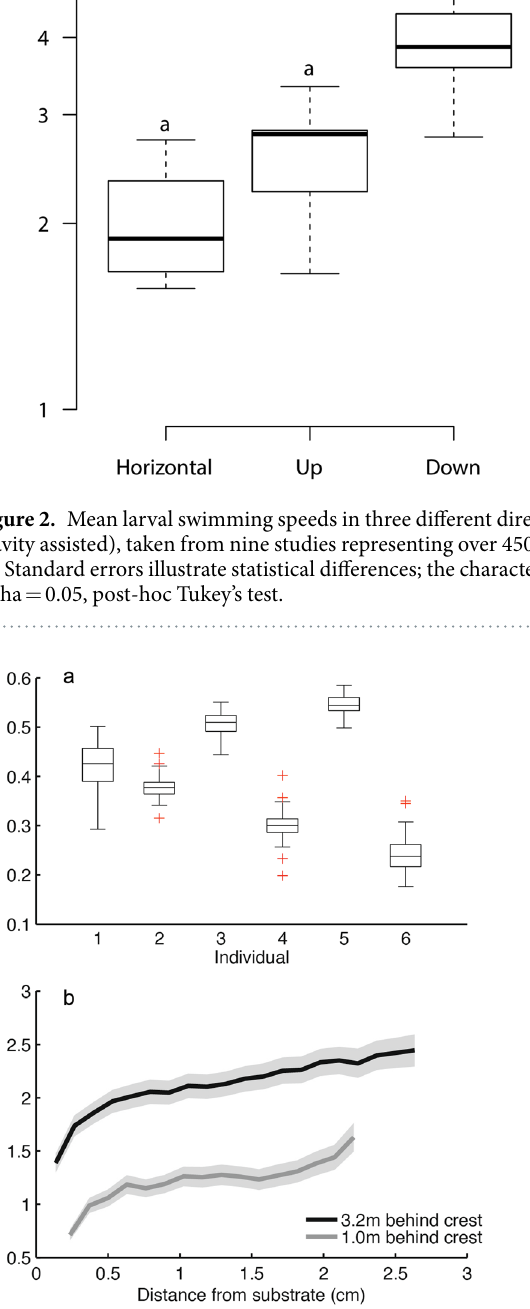
Figure 3. Swimming on the reef. ( a ) Swimming speeds of Isopora cuneata larvae measured in still water. Box plots show the median, interquartile range, ± 1.5 interquartile range with outliers in red. ( b ) Mean water velocities above the substratum at two positions back from the reef edge at Lizard Island (Great Barrier Reef, Australia) measured using particle image velocimetry. Grey bands represent 99% confidence